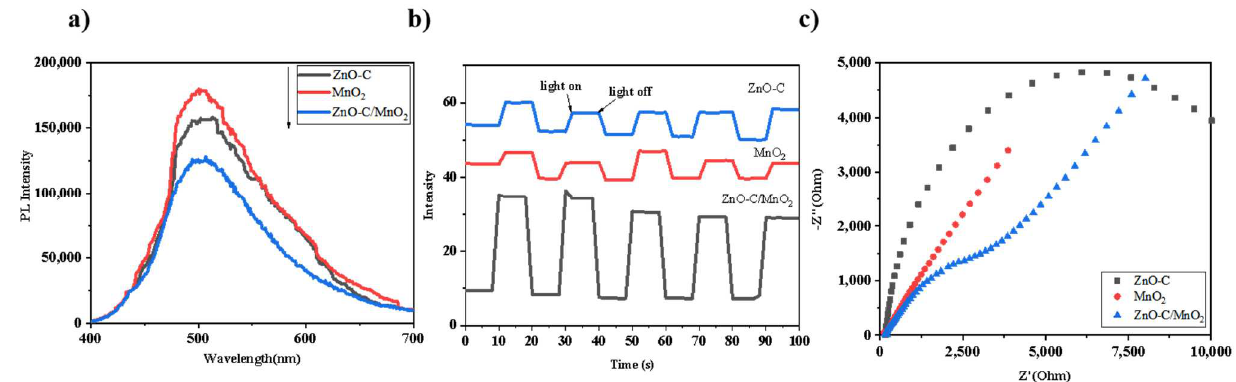
Figure 6. PL spectra of ZnO‐C, MnO 2 , and ZnO‐C/MnO 2 under 370 nm excitation ( a ); transient photocurrent responses of ZnO‐C, MnO 2 , and ZnO‐C/MnO 2 under xenon lamp irradiation ( b ); electrochemical impedance spectroscopy of ZnO‐C, MnO 2 , and ZnO‐C/MnO 2 ( c ).